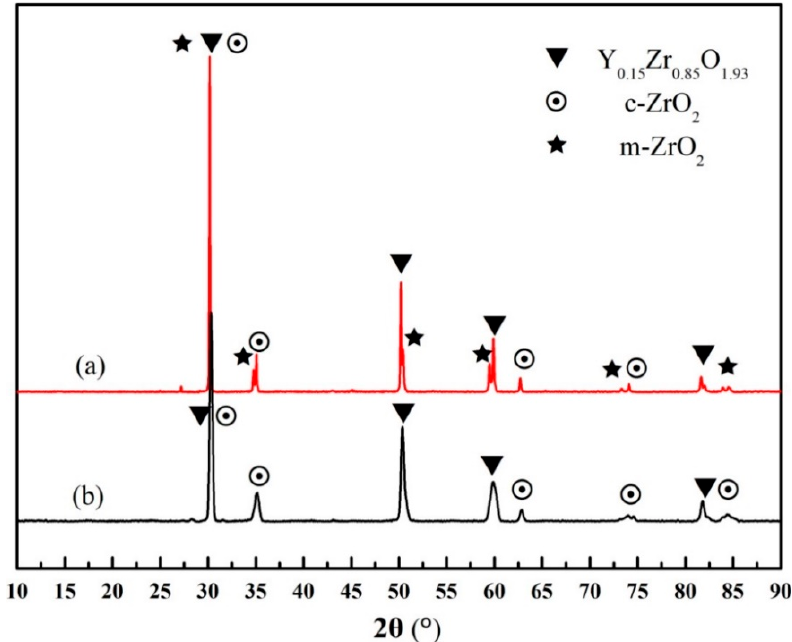
Figure 9. XRD patterns of ( a ) the O-AS powders and ( b ) C-AS particles.